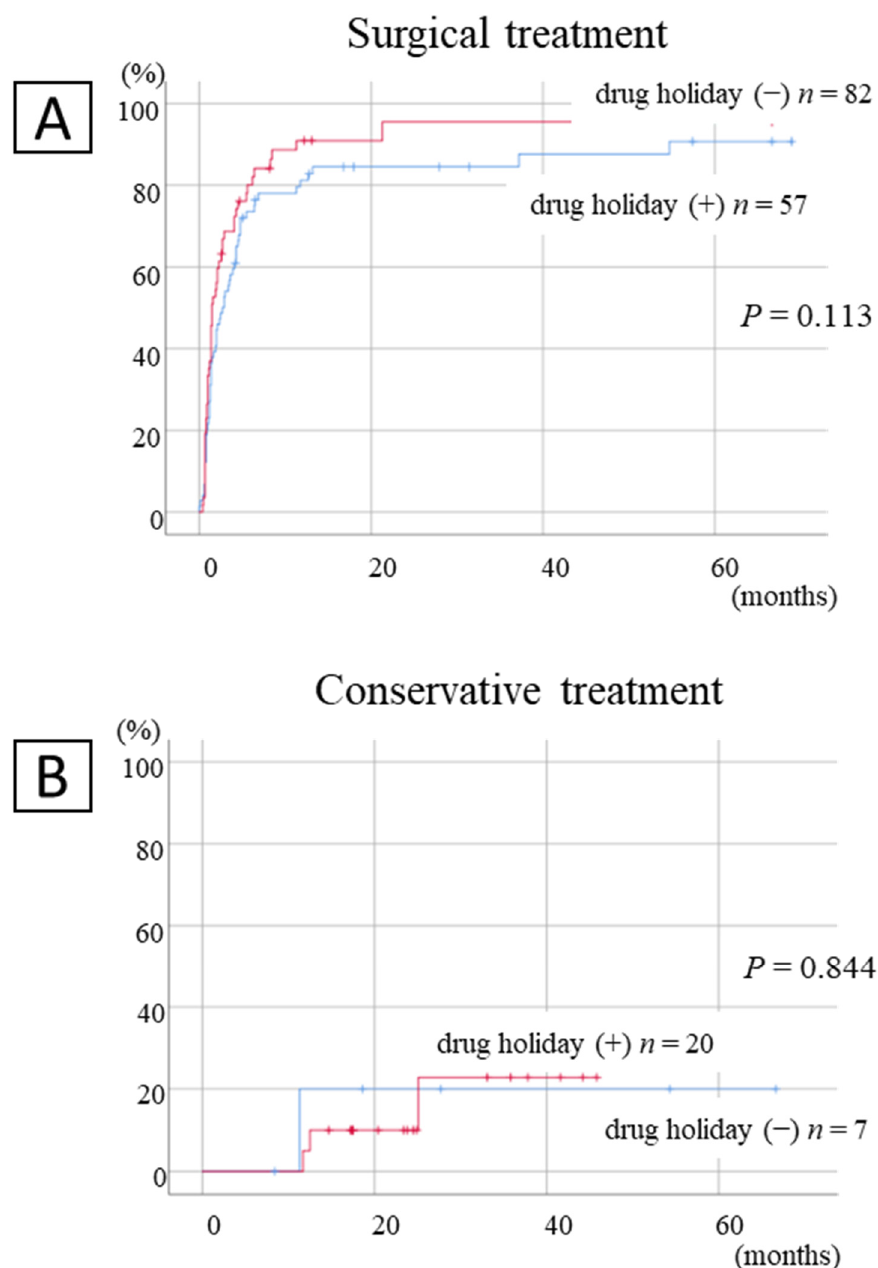
Figure 3. Cumulative healing rate by drug holidays. ( A ): Patients undergoing surgical treatments and ( B ): patients undergoing conservative treatments.